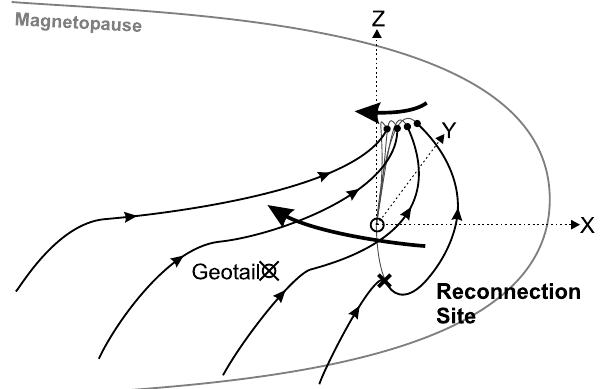
Fig. 12. An artistic rendering of the evolution of a flux tube that reconnected at high southerly latitudes in the prenoon sector and convects past Geotail ( ◦× G) on the dawn